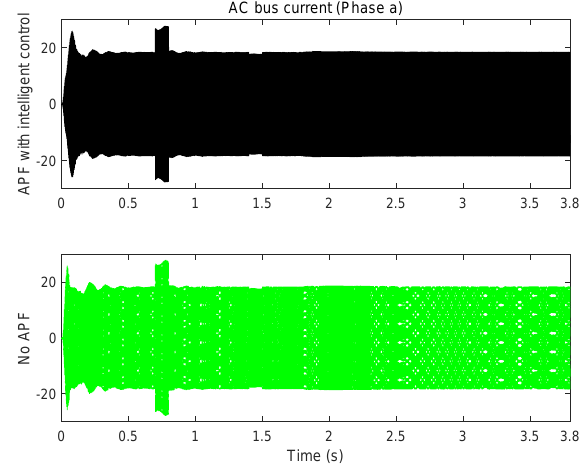
Figure 24. AC bus current (Phase